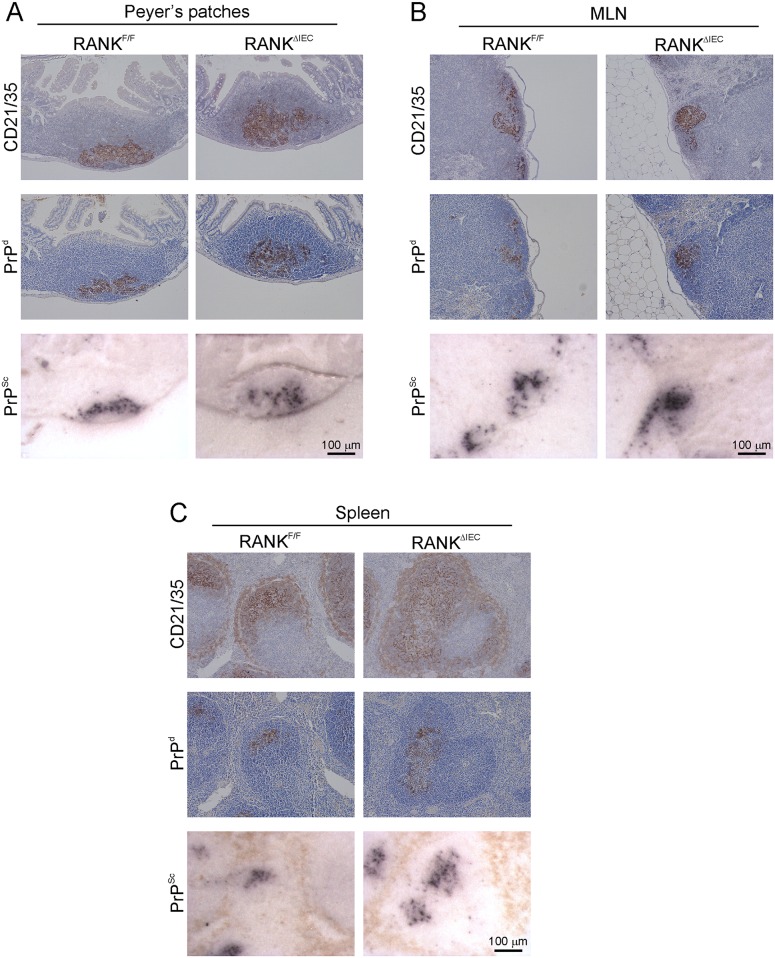
Prion accumulation upon follicular dendritic cells (FDC) after intra-peritoneal injection is preserved in RANKΔIEC mice.Since prions do not need to cross the gut epithelium to eventually infect Peyer’s patches after injection by the intra-peritoneal route, RANKΔIEC and RANKF/F (control) were injected with a 1% dose of ME7 scrapie prions via this route and tissues collected at 140 d post-infection, to determine whether the FDC in the lymphoid tissues of RANKΔIEC mice were capable of accumulating prions. High levels of disease-specific PrP (PrPd, brown, middle rows) were detected in association with FDC (CD21/35+ cells, brown, upper panels) in the Peyer’s patches (A), mesenteric lymph nodes (MLN, B), and spleens (C) of mice from each group. Sections were counterstained with haematoxylin to detect cell nuclei (blue). Analysis of adjacent sections by PET immunoblot analysis confirmed the presence of prion-specific PK-resistant PrPSc (blue/black). Images are representative of 4 mice/group.